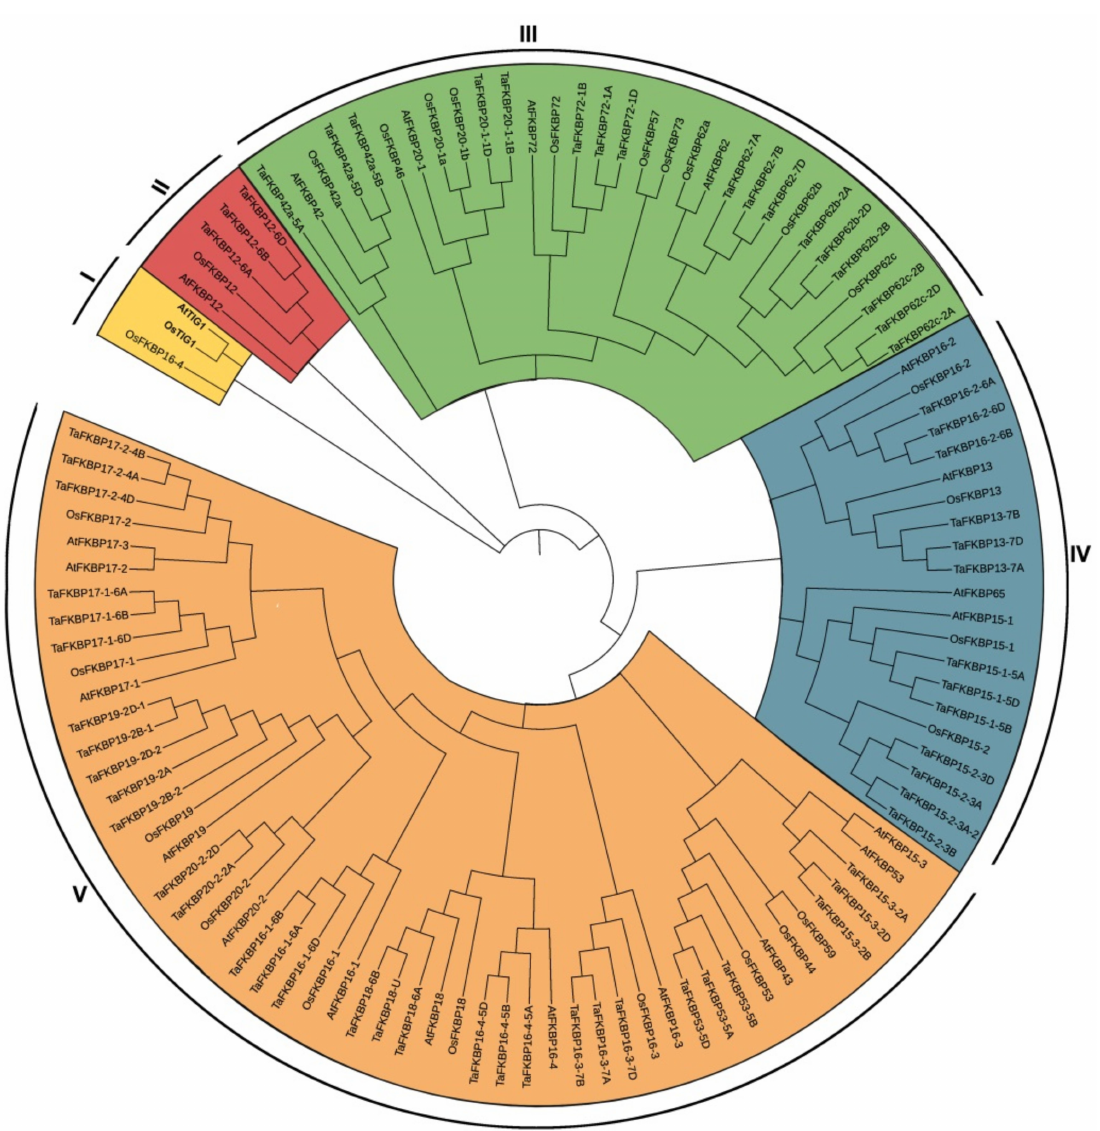
Figure 1. Phylogenetic tree of TaFKBPs. The phylogenetic tree was constructed by using the neighbor- joining method with 1000 bootstrap replications with MEGA